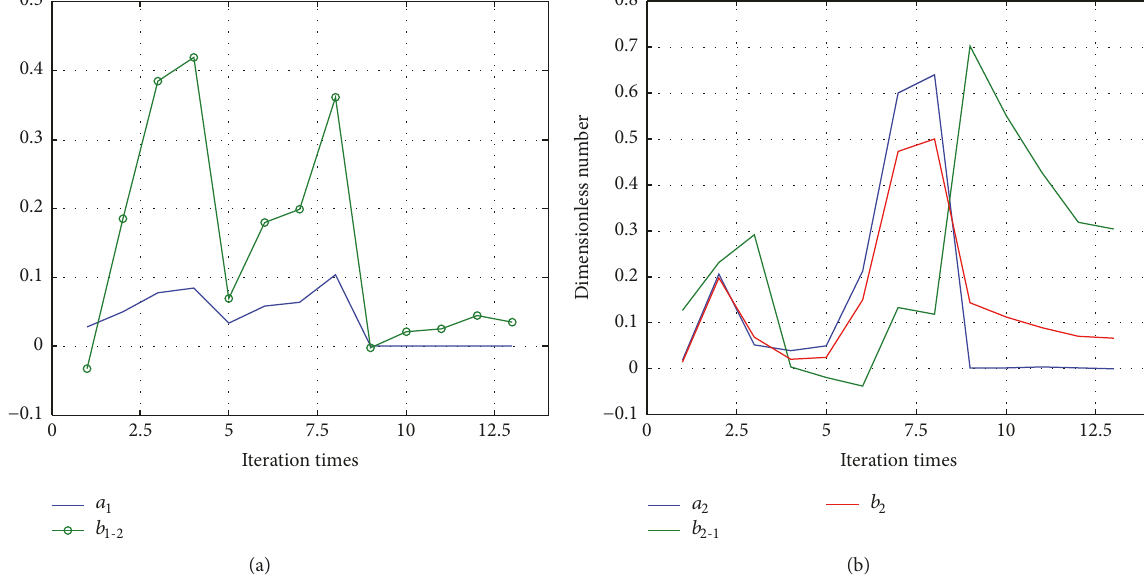
(variable parameters) and then make the new prediction. The cyclic action means that incremental learning takes